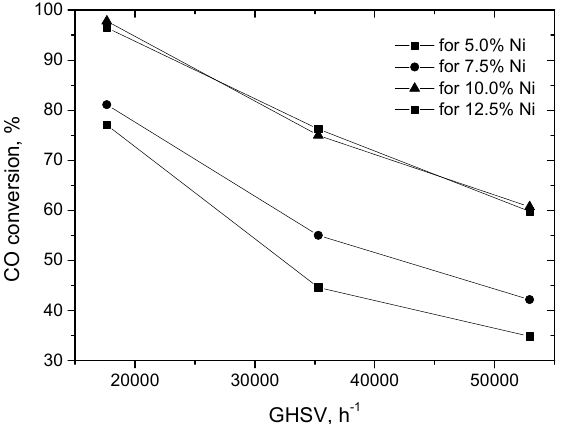
Figure 11. Effect of GHSV on CO conversion for catalysts with different nickel loading at 400 °C.